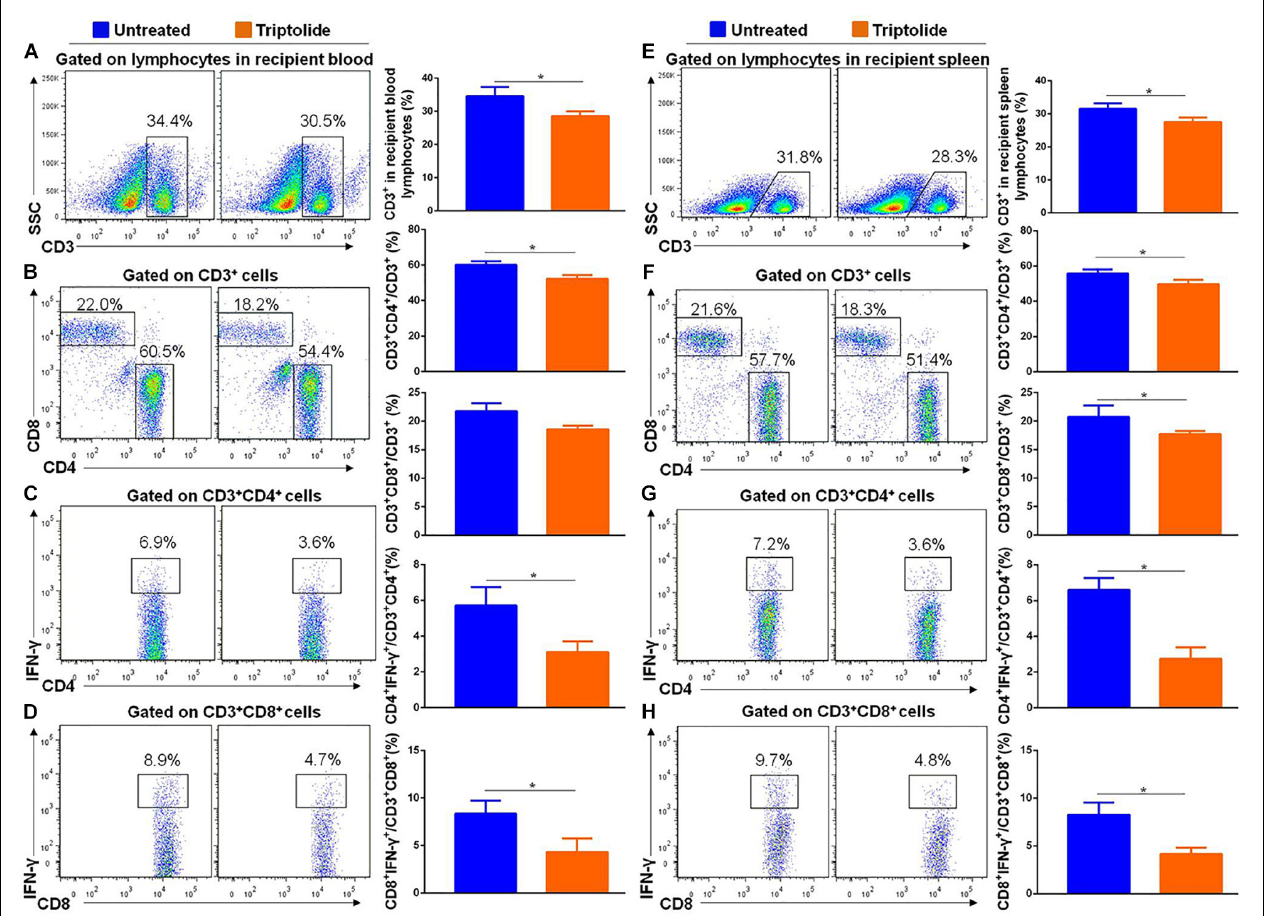
FIGURE 4 | Triptolide reduces the number of IFN- γ –producing T lymphocytes in recipient blood and spleen. Aortic allograft animals were treated with triptolide or without for 4 weeks after transplantation. T cells in recipient blood and spleen were detected by flow cytometry. Representative dot plots, cell percentages, and counts of CD3 + , CD3 + CD4 + , CD3 + CD8 + , CD4 + IFN- γ + , and CD8 + IFN- γ + T cells in recipient blood (A–D) and spleen (E–H) were shown. Data were represented as mean ± SD of at least three independent samples. * p < 0.05; Student’s t